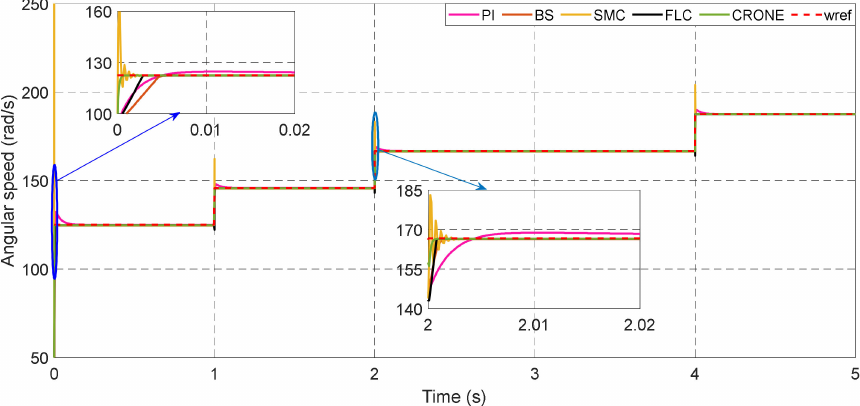
Figure 14. Angular rotor speed for PI, BS, SMC, FLC, and CRONE